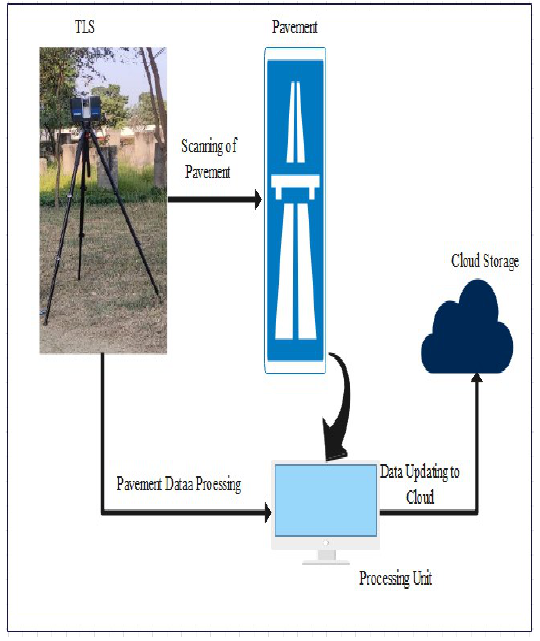
Figure 1 . Architecture of road pavement monitoring